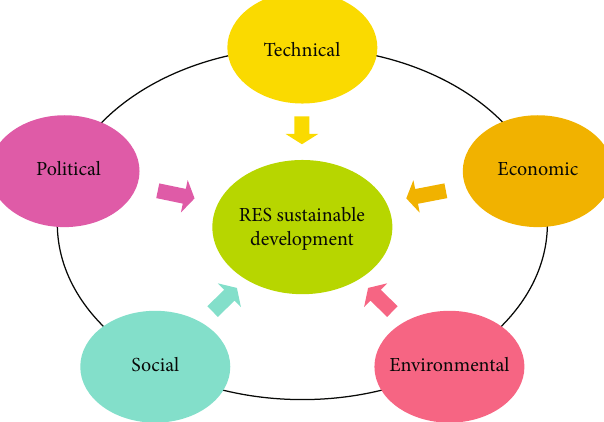
Figure 16: Dimensions of energy sustainability